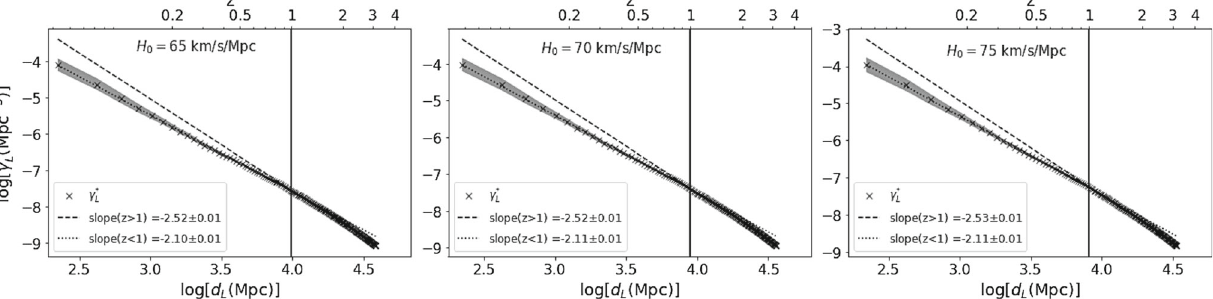
Fig. 7 Log–log graph of γ ∗ vs. d L obtained with the SPLASH galaxy redshift survey dataset in the ranges z < 1 and 1 ≤ z ≤ 4 and respective L distance measures